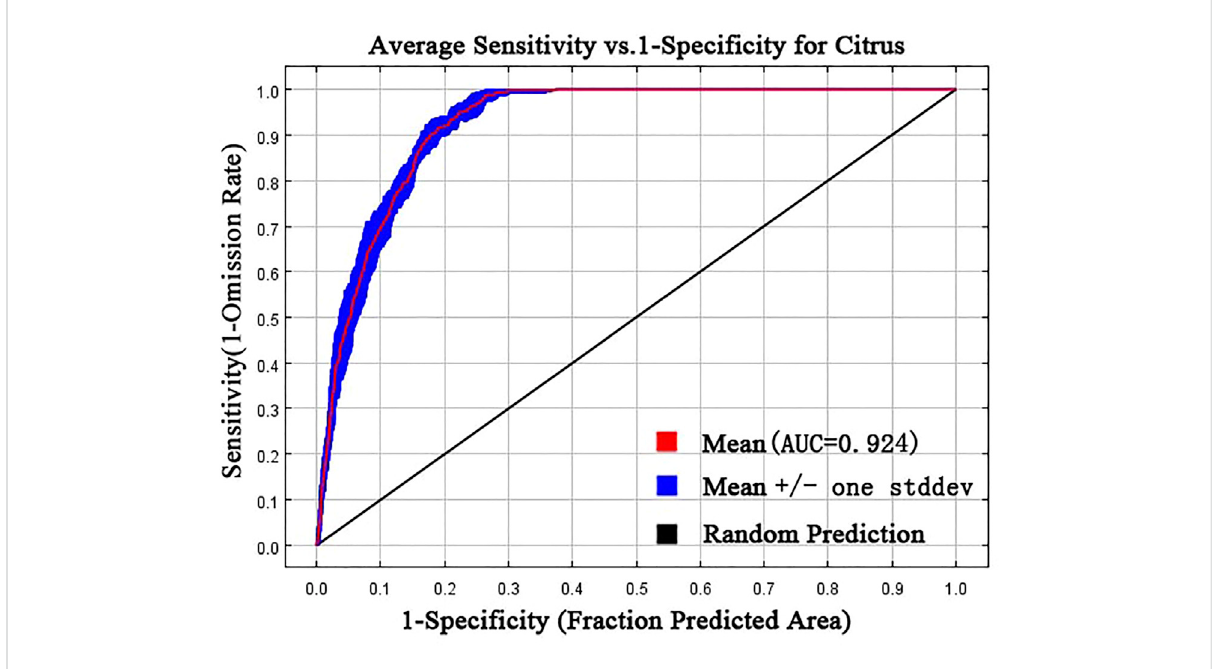
FIGURE 3 ROC curve and AUC value of